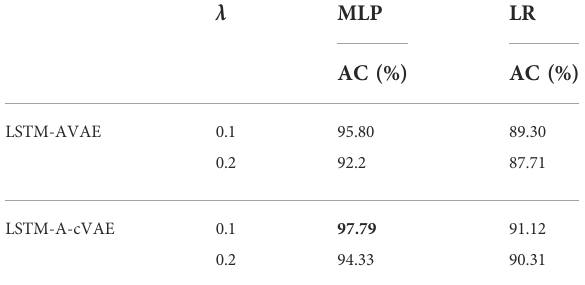
TABLE 4 Impact of conditional decoder on